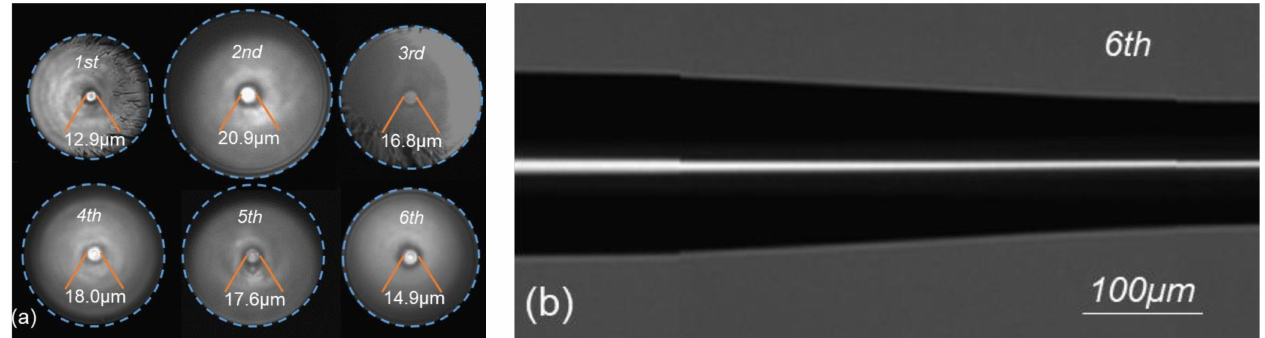
Figure 2. ( a ) The cross-sectional images of the MFAs obtained through six iterations of the reverse tapering technique, among which the 6th sample’s mode field diameter can match that of the fundamental mode in the OM3 fiber. ( b ) The side view of the MFA, thickened slowly and smoothly from right to left.